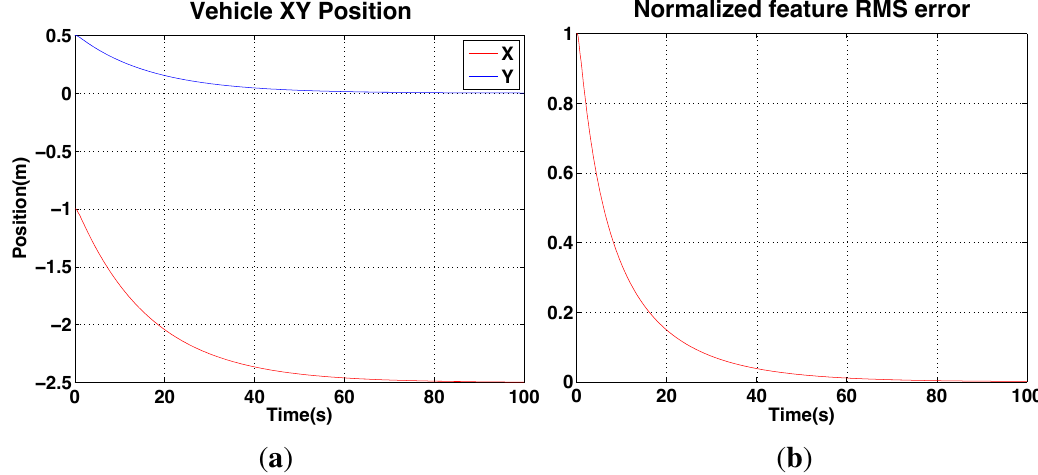
Figure 14. Simulation results for IBVS (with de-rotation): position response. ( a ): vehicle position ( x, y ) versus time showing the vehicle achieves its goal (x = 60 s; ( b ) the normalized root mean squared feature error ( (cid:96) ∗